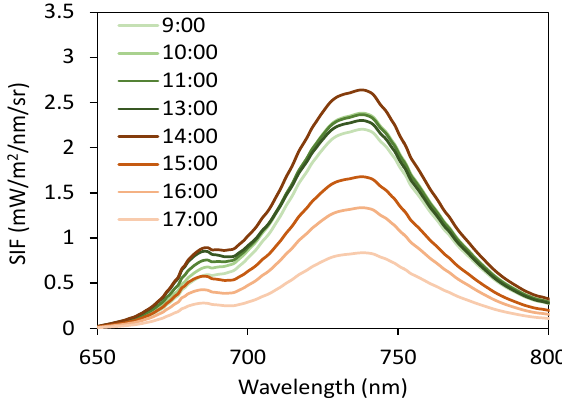
Figure 9. The full-spectrum SIF retrieved from the diurnal field measurements made by the QE Pro on 25 April, 2015. For clarity, only measurements made on the hour from 9:00 to 17: 00 are plotted.